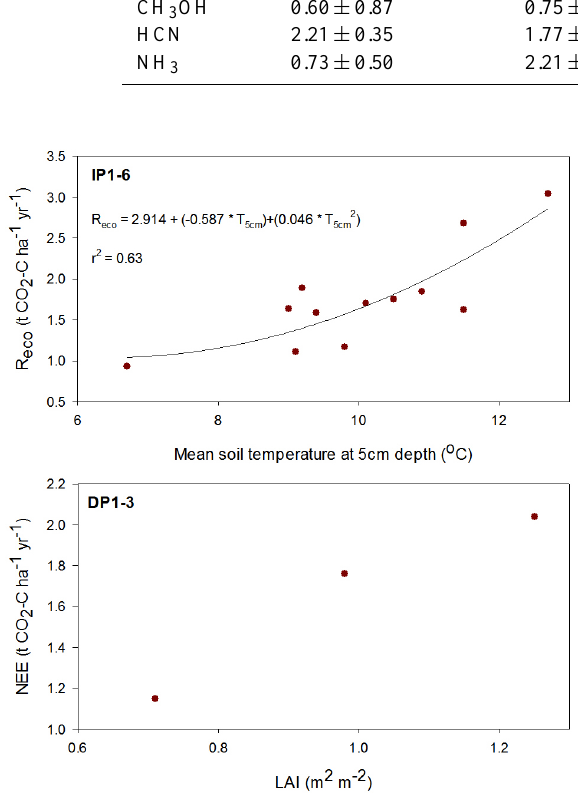
Figure 6. Relationship between (a) ecosystem respiration ( R eco : tCO 2 -Cha − 1 yr − 1 ) and mean soil temperature ( ◦ C) at 5cm depth at the IP sites and (b) net ecosystem exchange (NEE: tCO 2 - Cha − 1 yr − 1 ) and leaf area index (LAI:m 2 m − 2 ) . Circles indicate an annual